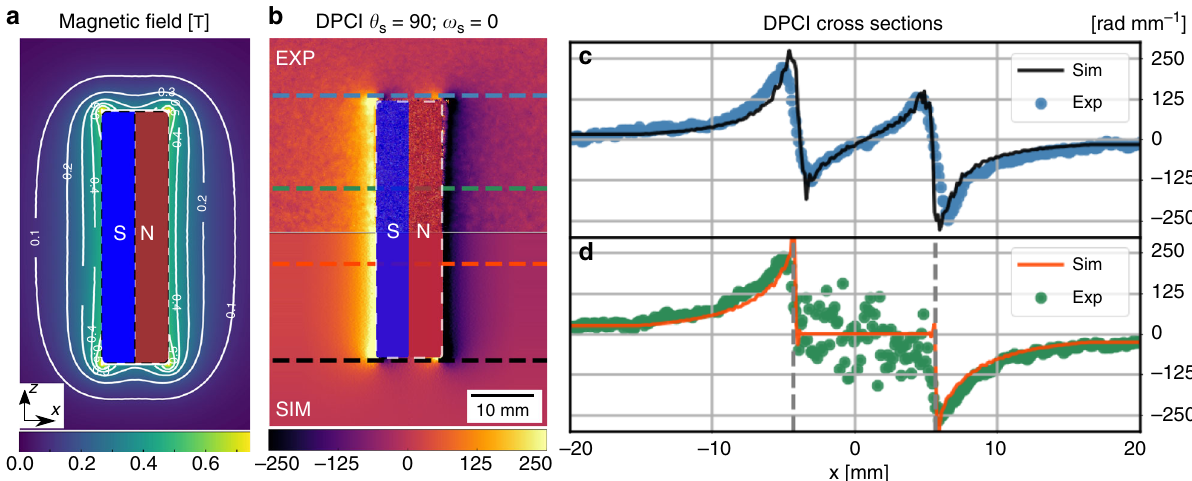
Fig. 8 Quantitative analysis of an inhomogeneous and anisotropic magnetic fi eld. Case: θ s = 90°, ω s = 0°. a Cross-section of the magnetic fi eld distribution along the x – z plane the cross-section. b Differential phase contrast image (DPCI) images, the top one is the retrieved from the experimental data while the bottom one is calculated from the fi nite element method (FEM) simulations. The two horizontal line pro fi les are mirrored at the same heights in both experimental and simulated images. c Comparison plot of the horizontal line pro fi le at the top/bottom faces highlighting the swirling of the magnetic fi eld near the edge. d Comparison plot of the horizontal line pro fi le at the middle height of the permanent magnet. The area within the vertical dashed lines shows the overlap with the neodymium permanent magnet where there is no transmission, and therefore no DPCI